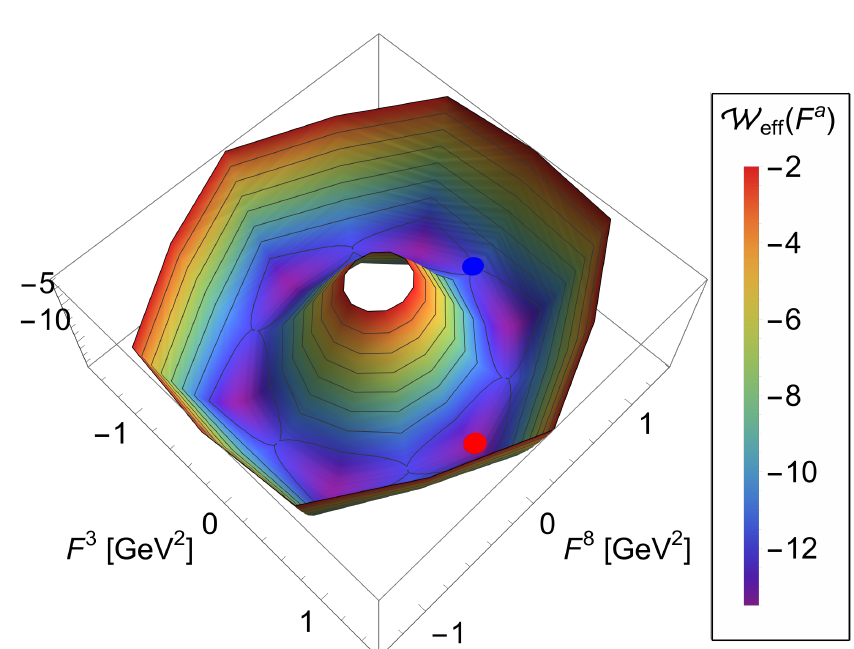
( F a ) in the plane spanned by the Cartan subalge- Figure 1: Effective potential W eff bras. The position of the non-trivial global minimum is highlighted in